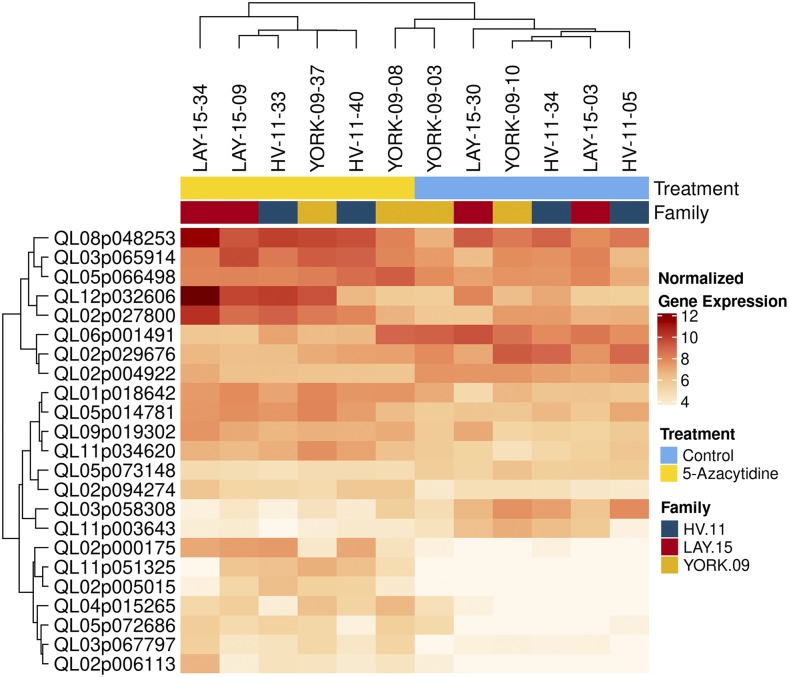
Heatmap of gene expression for the genes that were differentially expressed between Quercus lobata seedlings treated with demethylating agent 5-Azacytidine (n = 6) vs. control (n = 6). Cells show the normalized gene expression for a given gene and individual (darker colors are more highly expressed). Both samples and genes are clustered by similarity in gene expression (using the “complete” method of the hclust function in R).